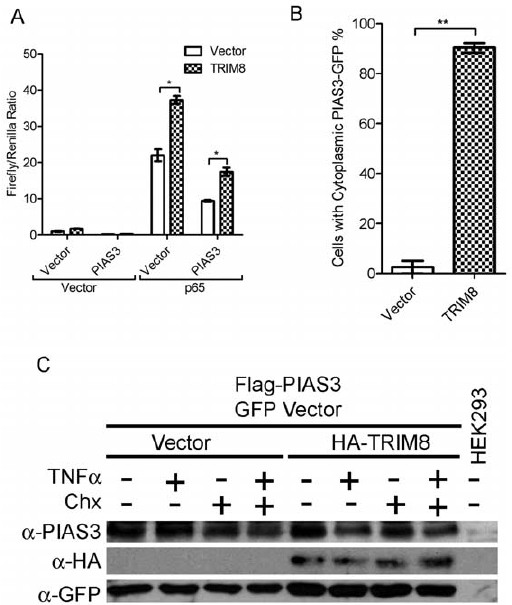
Figure 3. TRIM8 negates PIAS3 mediated NF- k B suppression. (A) TRIM8 recovers PIAS3 mediated NF- k B suppression. HEK293 cells were co-transfected with PIAS3, p65 and TRIM8 with vector and NF- k B luciferase reporter plasmids as described in materials and methods section. NF- k B activation was measured by Dual Glo luciferase assay. (B) Graphical representation of PIAS3 translocation. HeLa cells were transfected with HA-TRIM8, vector and PIAS3-GFP. After 24 hours of transfection, the cellular localization of PIAS3 was analyzed by confocal microscope. Asterisk (*) indicates data changes are statistically significant between groups: p value , 0.05 for SEM of minimum three independent experiments. (C) TRIM8 increases PIAS3 turnover in the presence of TNF. HEK293 cells were transfected with HA-TRIM8, Flag- PIAS3 and GFP vector. After 36 hours of transfection, cells treated with indicated chemicals (TNF a and Cycloheximide- CHX) and probed by anti-PIAS3, anti-HA and anti-GFP antibody.